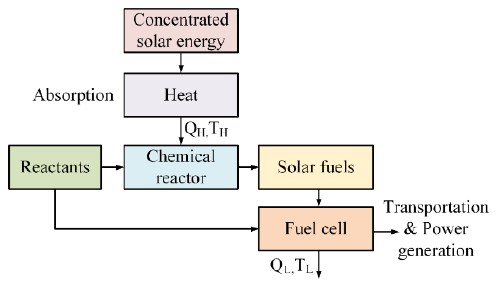
Figure 74. Manufacturing flowchart of solar fuels and subsequent use in fuel cells by using heat from concentrated solar power (CSP) [222].